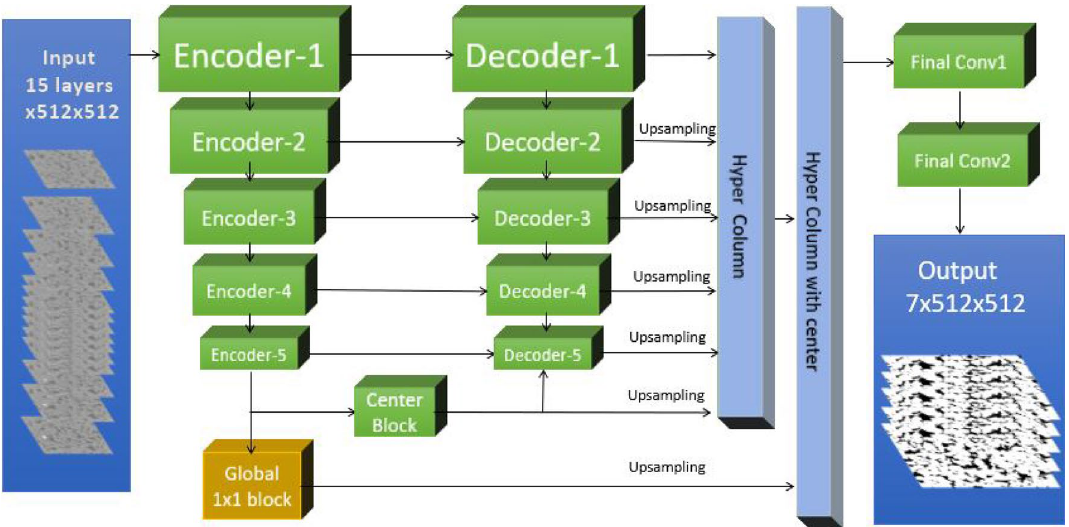
Figure 1. Architecture of the convolutional neural network model developed in this work. The model is based on an encoder-decoder architecture which takes a 3D image as input and split it in 2D slices (channels). In each iteration, the model takes 15 channels from 7 consecutive center layers and 8 skip layers as input. The model produces a 3D block of 7 consecutive channels as